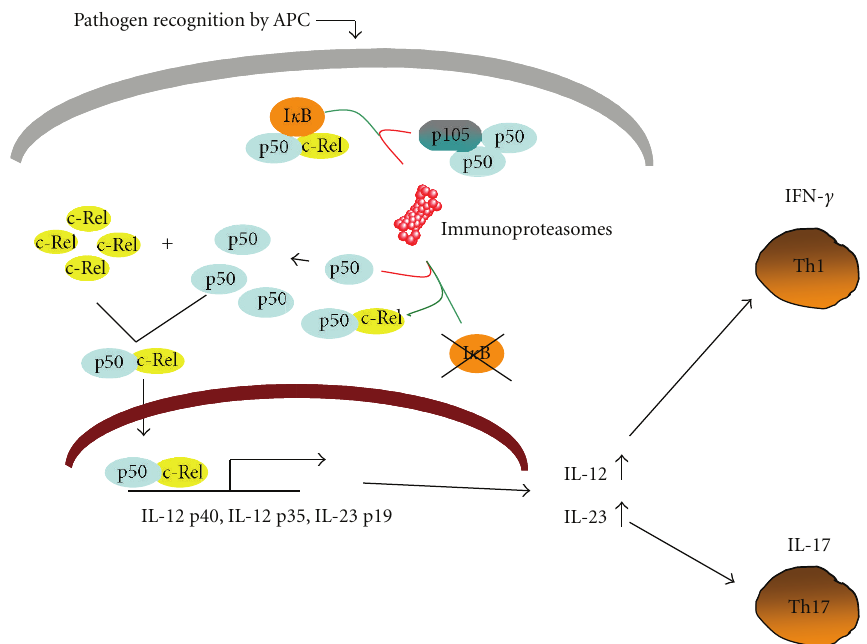
Figure 2: Induction of immunoproteasomes and c-Rel signalling in APC during intestinal inflammation. After disruption of intestinal barrier, the activation of DC by innate immunity triggers such as TLR ligands results in signalling cascade that induces expression of immunoproteasomes. The immunoproteasome is highly active form of proteasome that enhances activation of NF- κ B signalling. Additionally, stimulation of TLR releases c-Rel/p50 dimers from I κ B to bind to the p40, p35, and p19 promoter. The synergy between immunoproteasomes and c-Rel leads to an increase of IL-12 and IL-23 secretion by APC contributing directly to T-cell-mediated immune responses and exacerbation of intestinal